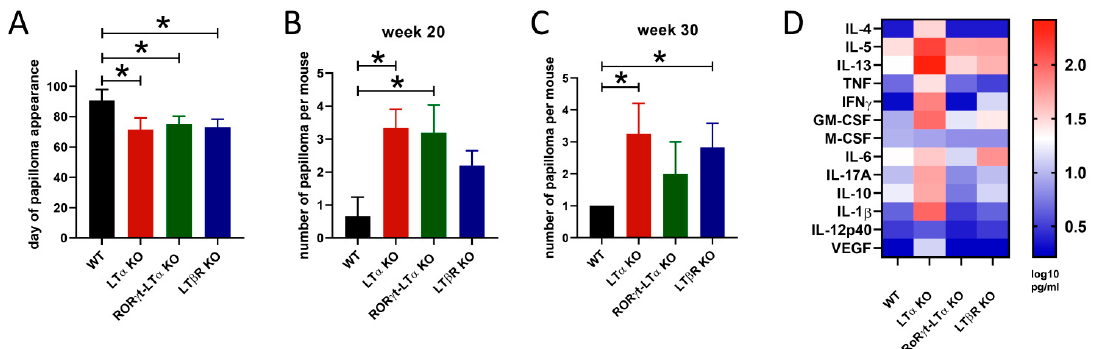
Figure 3. LT αβ –LT β R interaction protects mice from the development of DMBA/TPA chemically induced skin cancer. Mice [71–73] and the protocol for chemically induced skin carcinogenesis were previously described [66]. ( A ). Day of the first papilloma’s onset. * p < 0.05. ( B ). Number of papillomas per mouse at week 20 of the experiment. * p < 0.05. ( C ). Number of papillomas per mouse at week 30 of the experiment. * p < 0.05. ( D ). Heat map representing global variations in cytokine/chemokine responses (log 10 ) in mice of different genotypes at week 20 of the experiment, as determined by multiplex analysis. Cytokine and chemokine levels in mouse sera were measured simultaneously using a multiplex microbead-based immunoassay, MILLIPLEX MAP Mouse Cytokine/Chemokine Magnetic Bead Panel-Premixed 32 Plex (MCYTMAG ‐ 70K ‐ PX32, Merck) according to the manufacturer’s protocol.